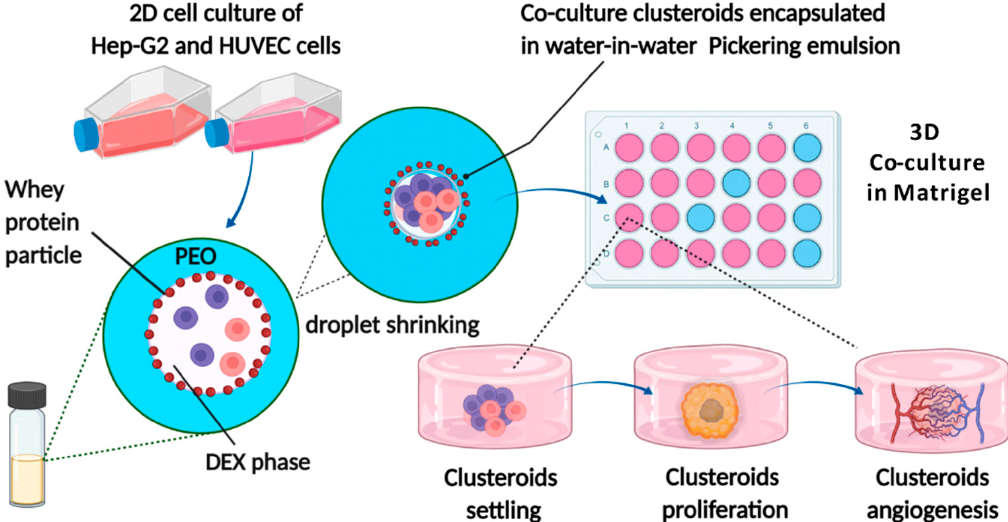
Figure 1. Schematic illustration of the HUVEC and Hep-G2 co-culture clusteroids in the w / w Pickering emulsion template and clusteroids angiogenesis. Created with